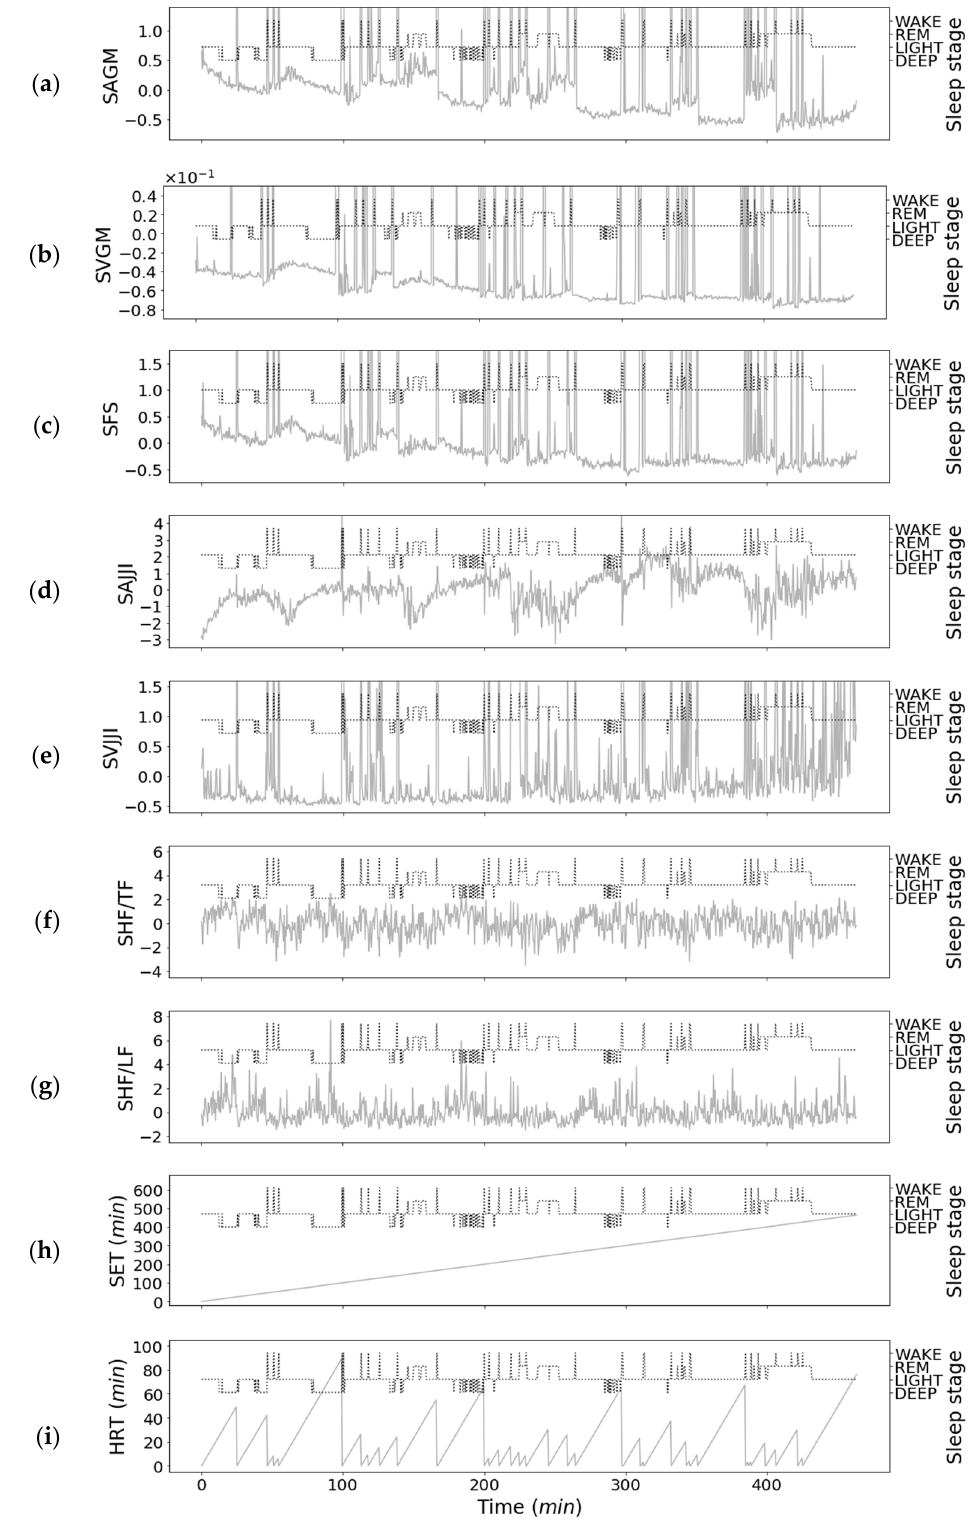
Figure 8. One subject’s overnight results with second-step classifier and sleep stage (Subject: 1, Day: 2): ( a ) Standardized average of gross movements; ( b ) Standardized variance of gross movements; ( c ) Standardized full spectrum; ( d ) Standardized average of JJI; ( e ) Standardized variance of JJI; ( f ) Standardized HF/TF; ( g ) Standardized HF/LF; ( h ) Sleep elapsed time; ( i ) Head rest time.